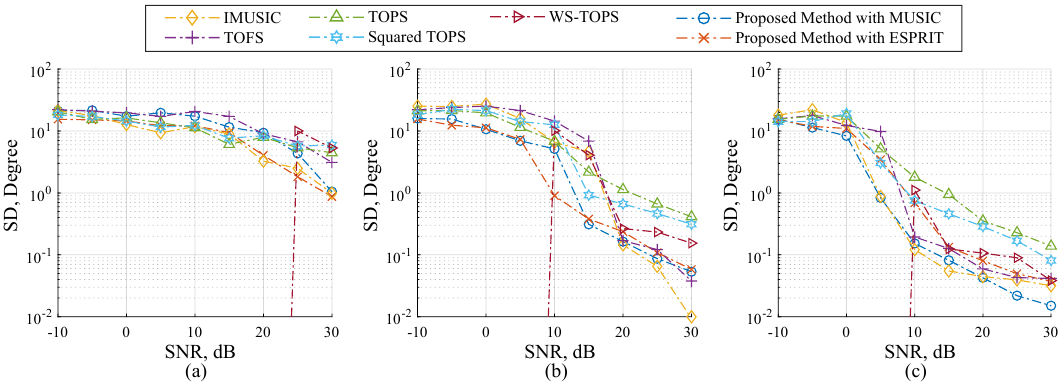
Figure 4. RMSE estimation performance versus SNR on Scenario 2; three human speeches are employed and the number of microphone elements each subarray on ( a ) N = 4, ( b ) N = 8, and ( c ) N = 12.